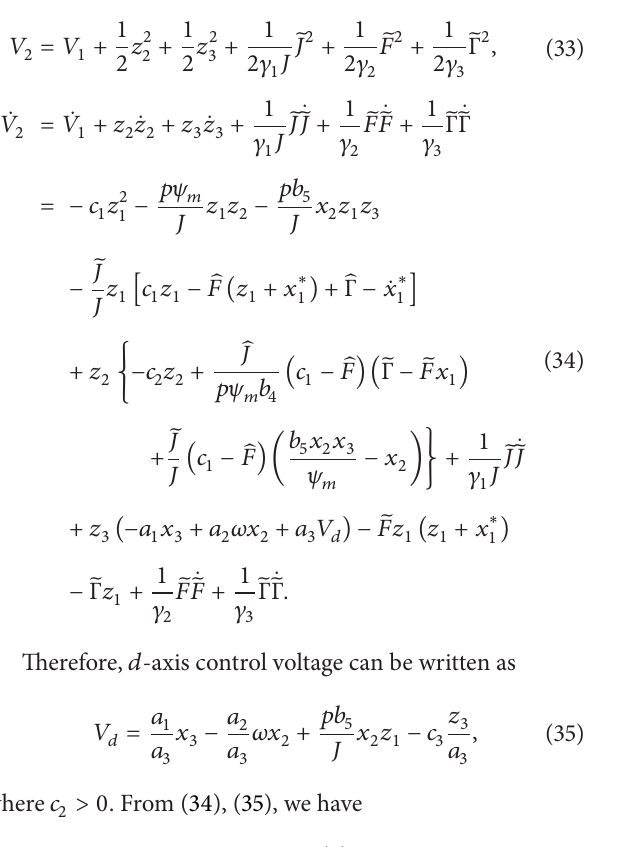
Figure 7: Floating wind